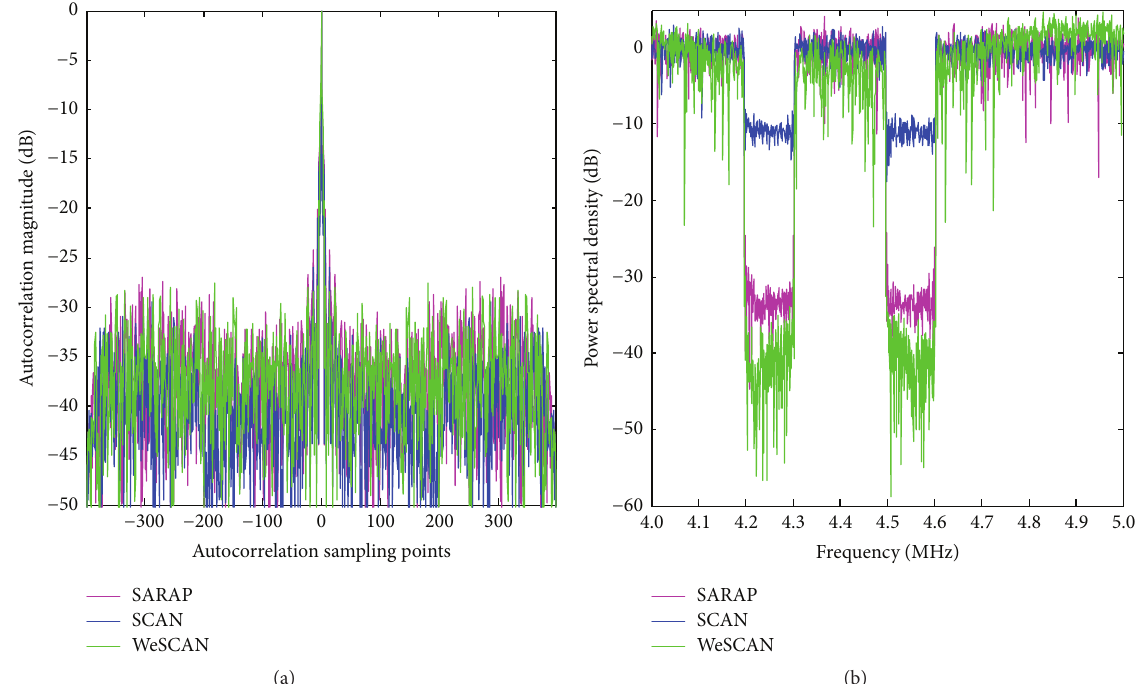
Figure 3: Autocorrelation magnitude and PSD comparison; (a) illustrates range sidelobes suppression; (b) illustrates multistopbands suppression.